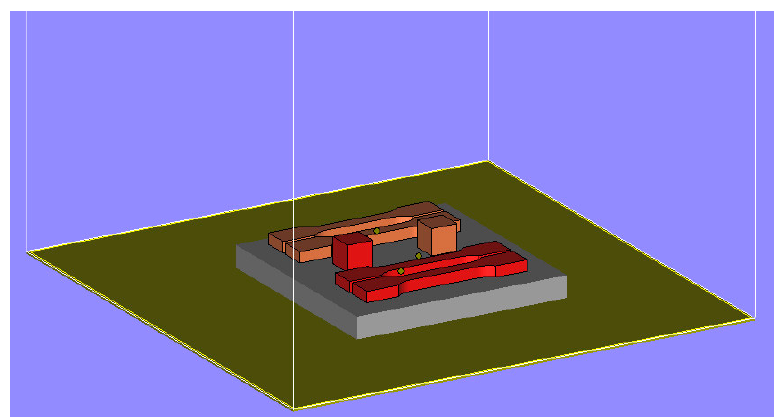
Figure 3. Arrangement of tensile and cube samples as modeled in Magics (Ver.17) software (Materialise NV, Leuven, Belgium).